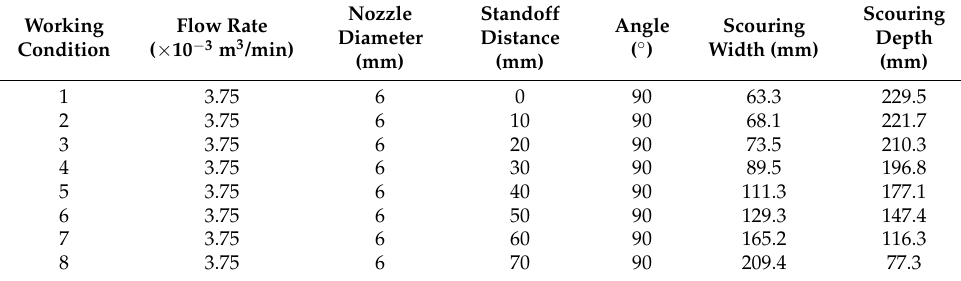
Table 5. Scouring effect at different standoff distances of nozzle. Working